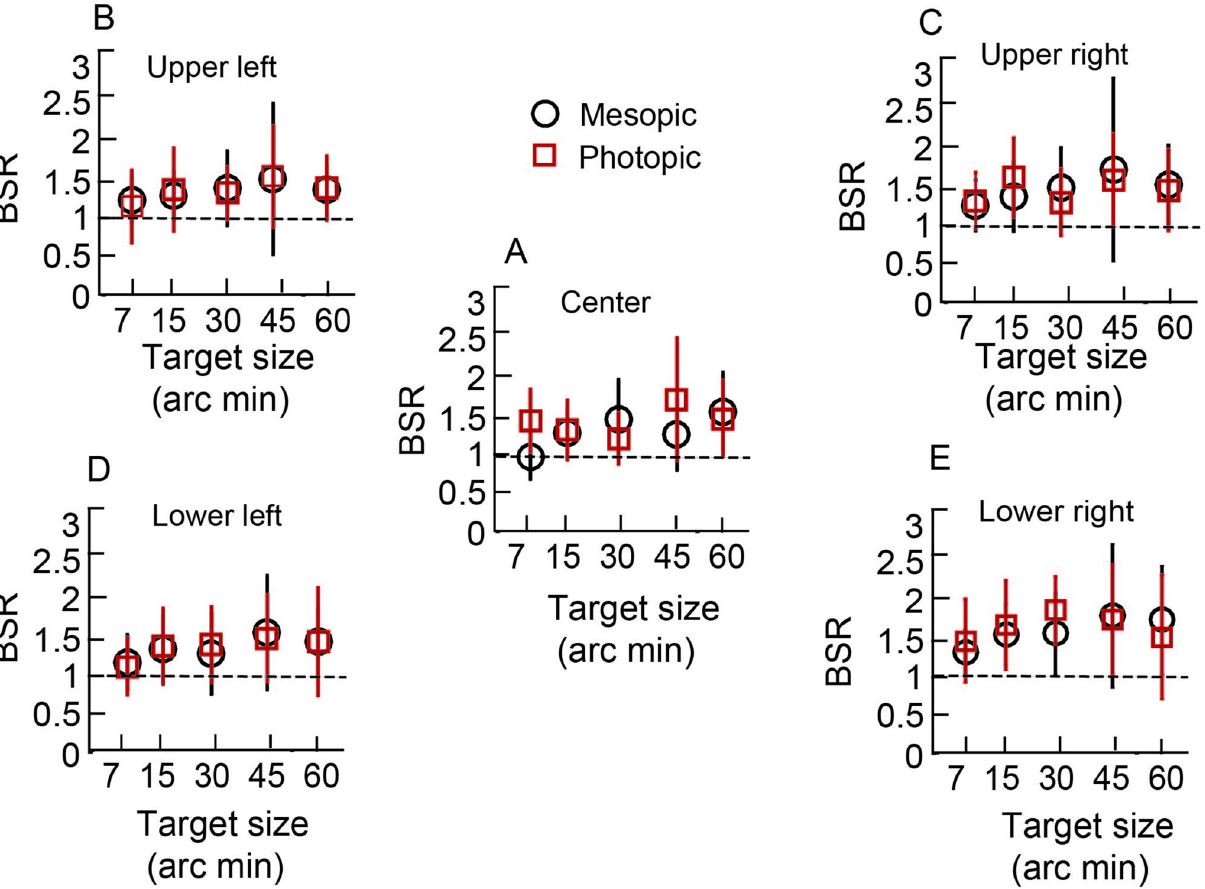
Fig 6. Binocular summation ratio. Mean ( ± 1SD) binocular summation ratio (BSR) of FMTs as a function of target size for the mesopic and photopic stimulus conditions at point of regard and the four parafoveal locations. Horizontal dashed line in each panel indicates no binocular summation.